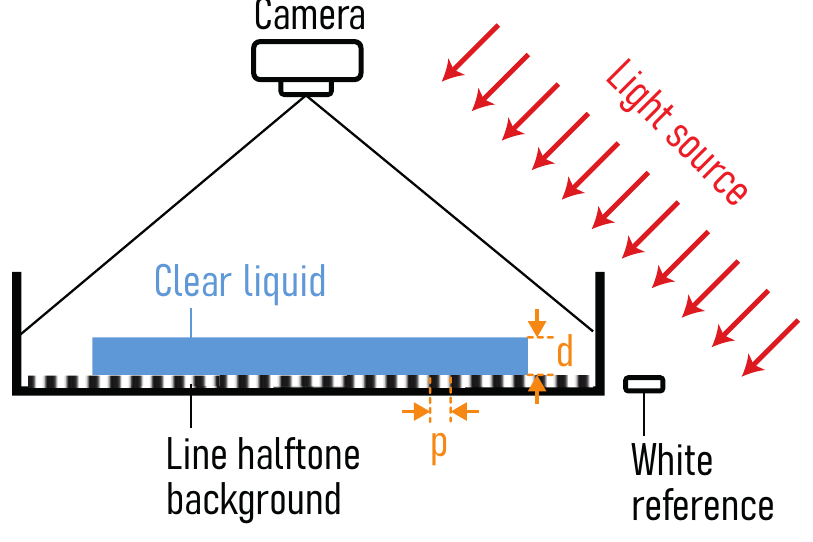
Figure 4. Experimental